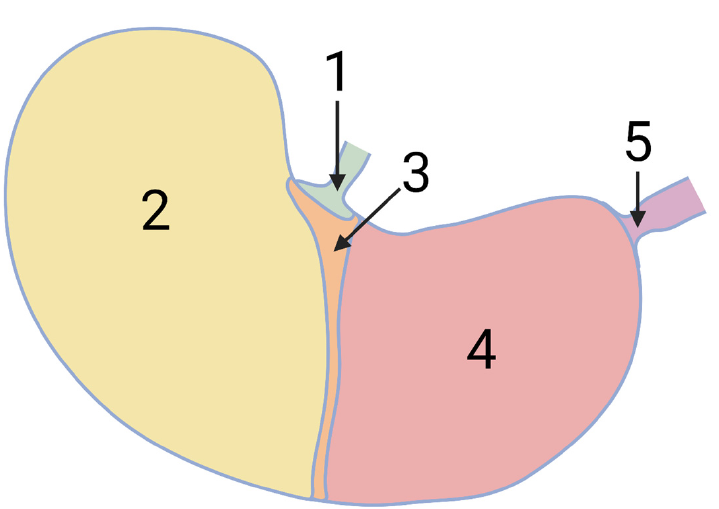
Figure 1. Schematic illustration of the rat stomach’s anatomy (1—cardia; 2—nonglandular stomach; 3—limiting ridge; 4—glandular stomach; 5—pylorus).